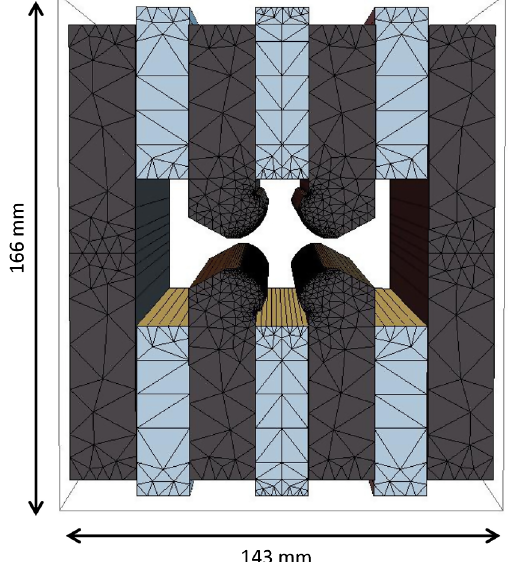
FIG. 3. 3D view of the R ADIA quadrupole model including the mesh. The mesh is based on multiple polyhedrons. The model is divided into ten longitudinal slices concentrated on the edge. The pole tip has a higher mesh density because the field computation accuracy mainly depends on this area. Several simulations with different mesh refinements on the pole shape are done to check the stability of the results.